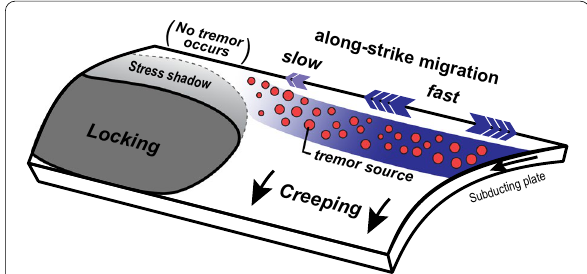
Fig. 5 Diagram of the relationship between interplate coupling and shallow tremor activity. When the boundary is creeping, shallow tremors can migrate along strike at a high rate. When the boundary is locked, tremors are less likely to migrate along strike due to the